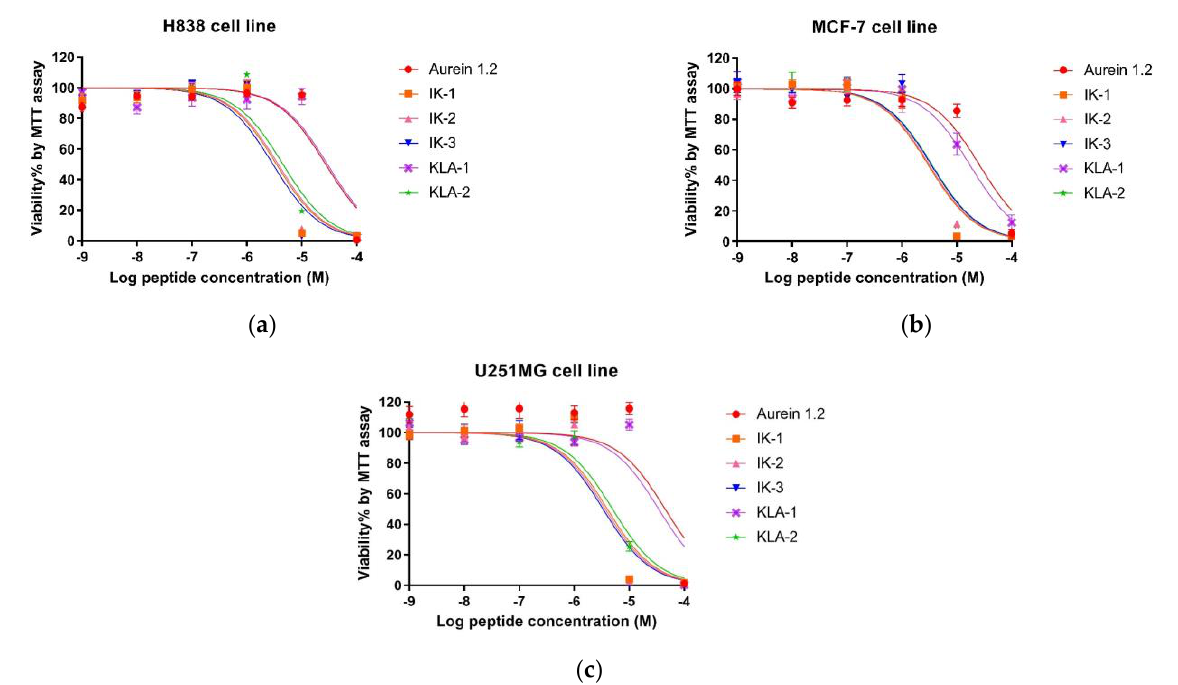
Figure 8. The effects of aurein 1.2 and its analogs on the proliferation of human cancer cell lines. ( a ) H838, non-small-cell lung cancer; ( b ) MCF-7, human breast cancer cell line; ( c ) U251MG, human glioblastoma astrocytoma. The cancer cells were treated with a series of peptide concentrations from 10 −9 M to 10 −4 M; 0.1% Triton X-100 was used as the positive control. The curves were fitted using normalized dose – response analysis. The error bar represents the means ± standard deviation of three independent experiments. Table 4. The calculated IC 50 values (μM) of aurein 1.2 and its analogs.